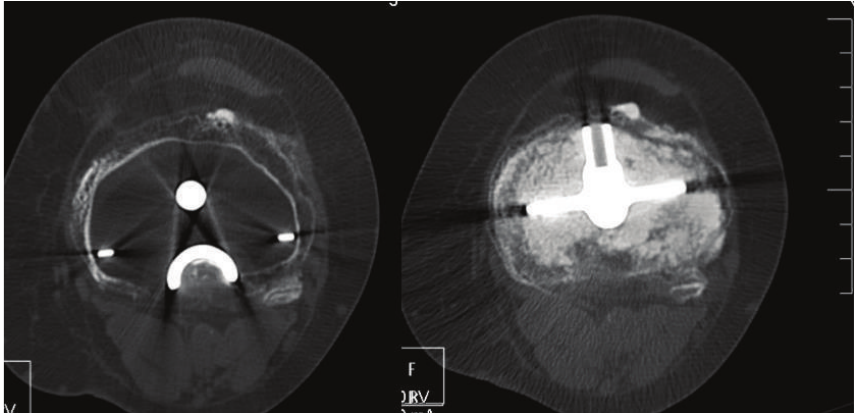
Figure 3: No lysis between cement and cancellous